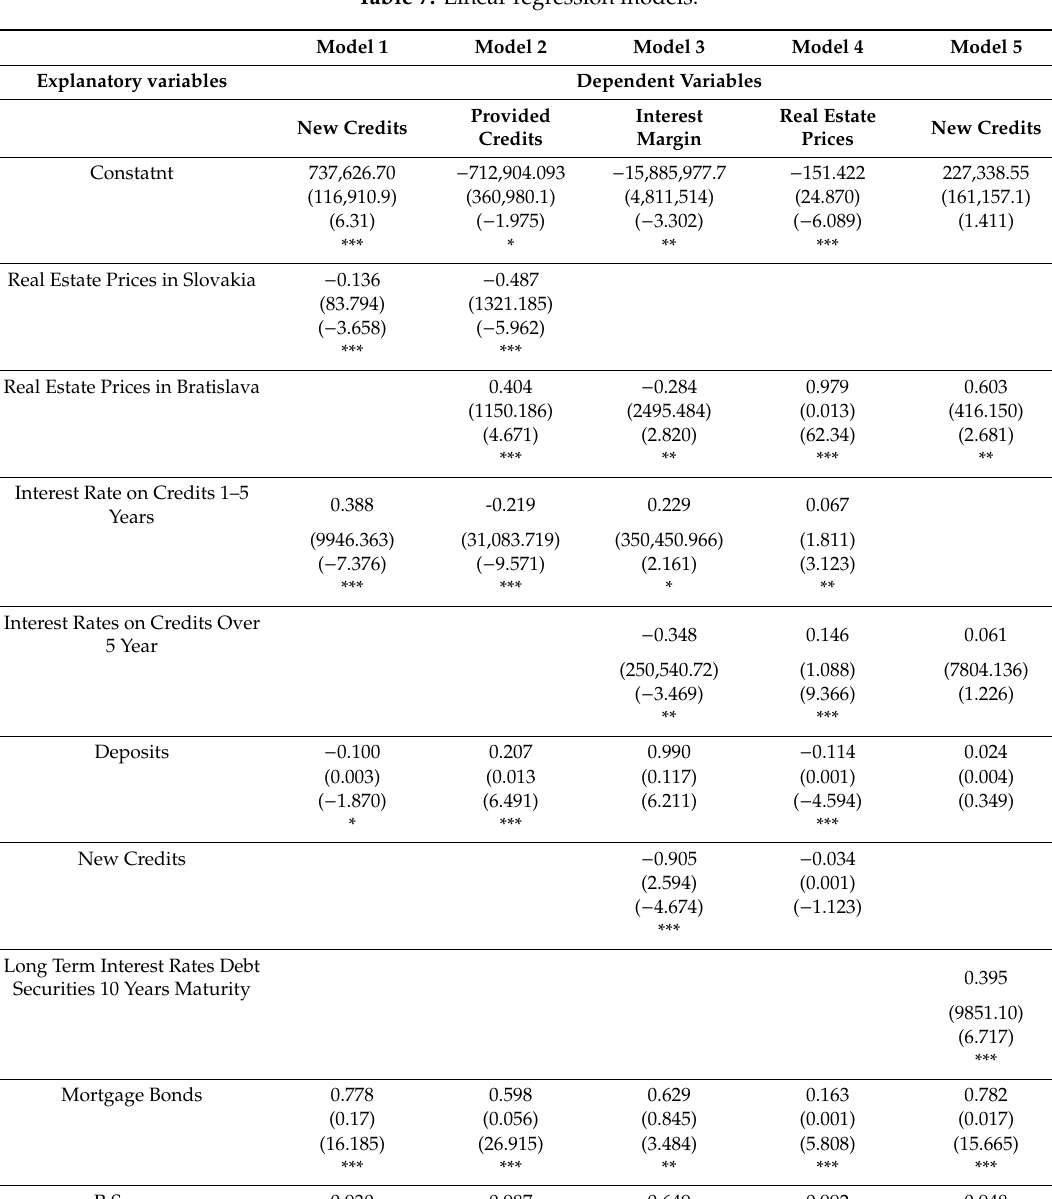
Table 7. Linear regression